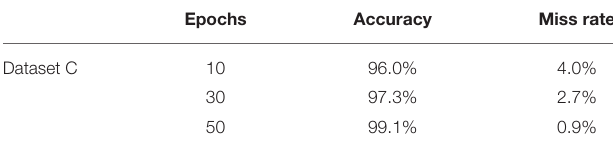
TABLE 7 | Training model on dataset C.